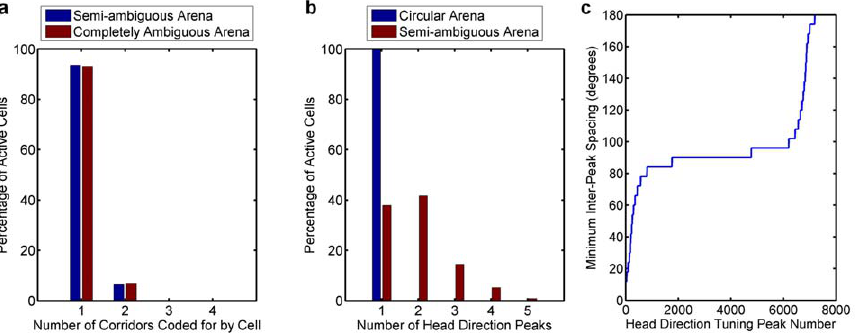
Figure 9. Place field distributions and tuning curve properties for the cell populations in the experimental arenas. (a) More than 6% of cells that were active at some time during the 80 trials encoded locations in two or more different corridors (semi-ambiguous: n=83551 cells, completely ambiguous: n=83460 cells). (b) Directional tuning of the cell populations was almost entirely unimodal in the circular arena experiment described in Figure 4 (n=2304 cells). However, in the corridor arena, more than 60% of active cells encoded more than one distinct robot orientation (n=5006 cells). (c) Distribution of the minimum inter-peak spacing for all cells encoding multiple robot orientations in the semi-ambiguous corridor arena (n=3111